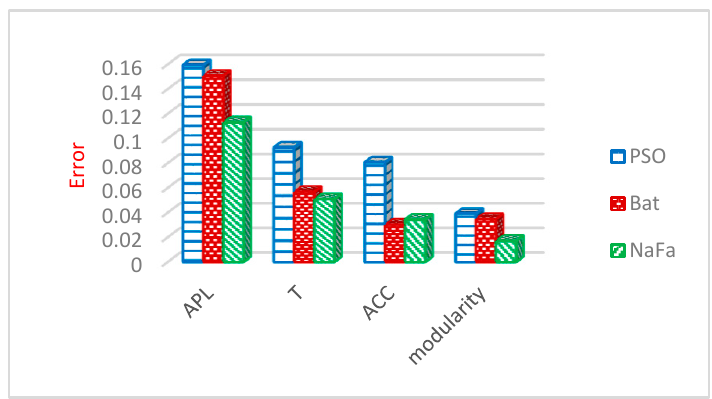
Figure 19. Average of error values on all datasets.